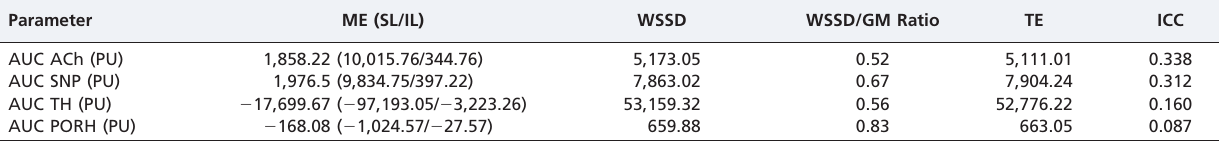
Table 2 - An assessment of the limits of agreement in the day-to-day measurements of skin microvascular reactivity using laser Doppler perfusion monitoring.